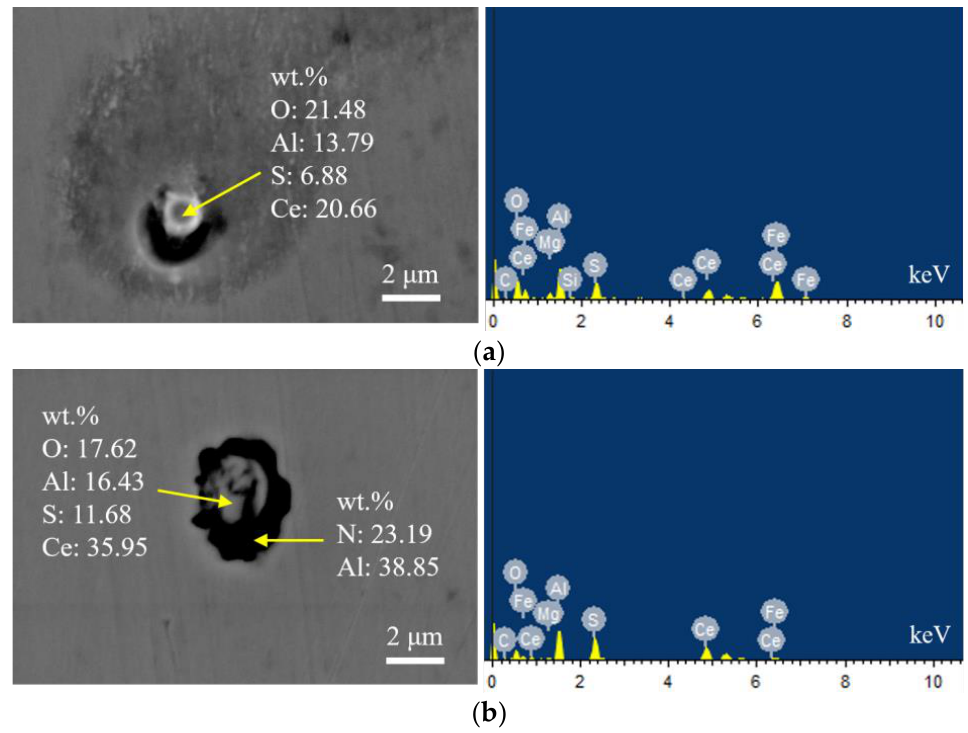
Figure 6. Typical morphology and energy spectrum of inclusions in the steel with 20 ppm Ce content.